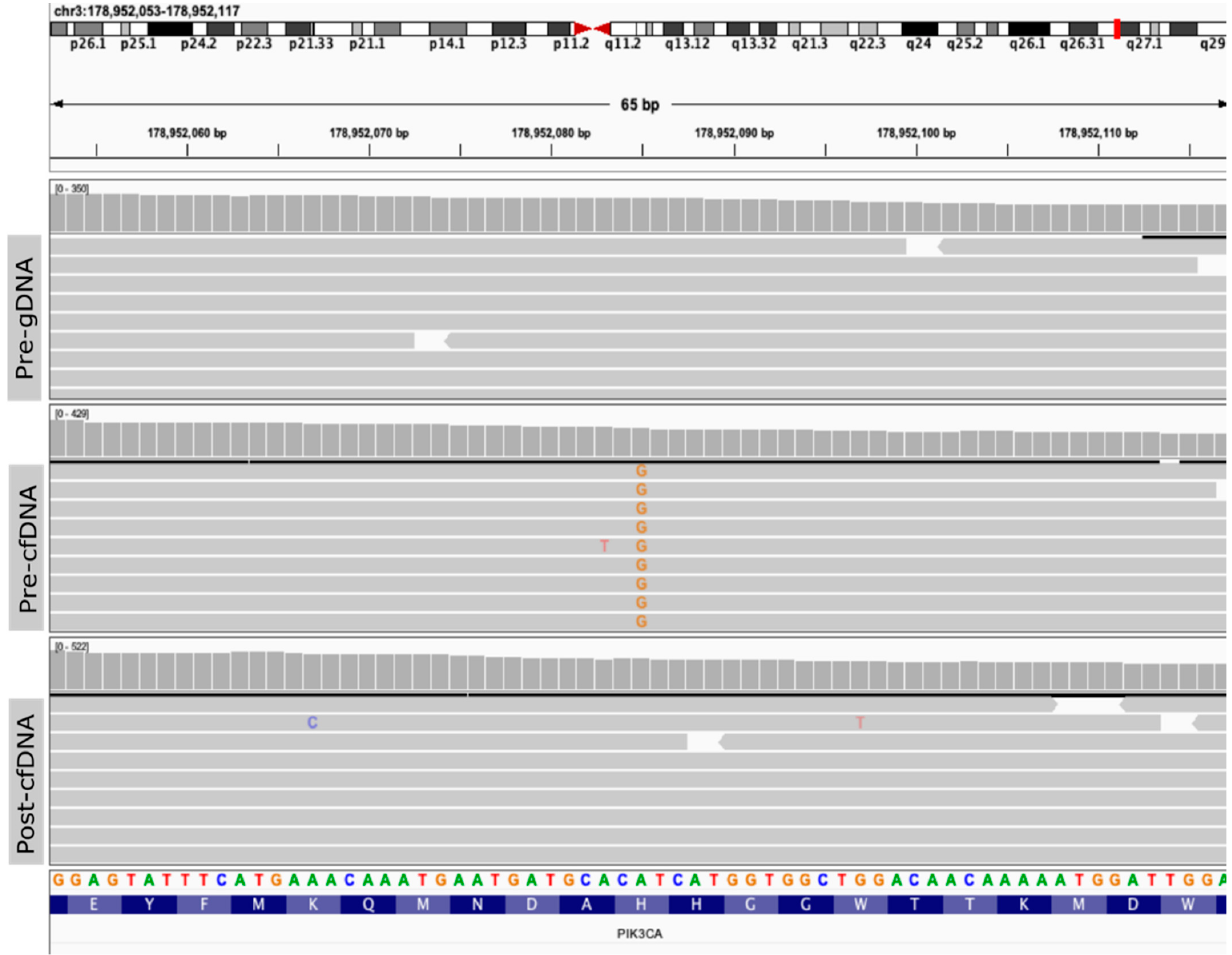
Figure 2. Integrative Genomics Viewer (IGV) screenshot of the PIK3CA variant detected in cell-free DNA using targeted massively parallel sequencing. The top panel depicts the sequencing reads of the genomic DNA from buffy-coat collected before treatment (Pre-gDNA). The middle and bottom panels depict the sequencing reads of the cell-free (cf)DNA collected before (Pre-cfDNA) and after (Post-cfDNA) treatment with ribociclib plus letrozole. PIK3CA hotspot mutation (3:178952085, A > G, H1047R) was detected only in cfDNA before treatment (middle, alternate alleles are shown in orange).